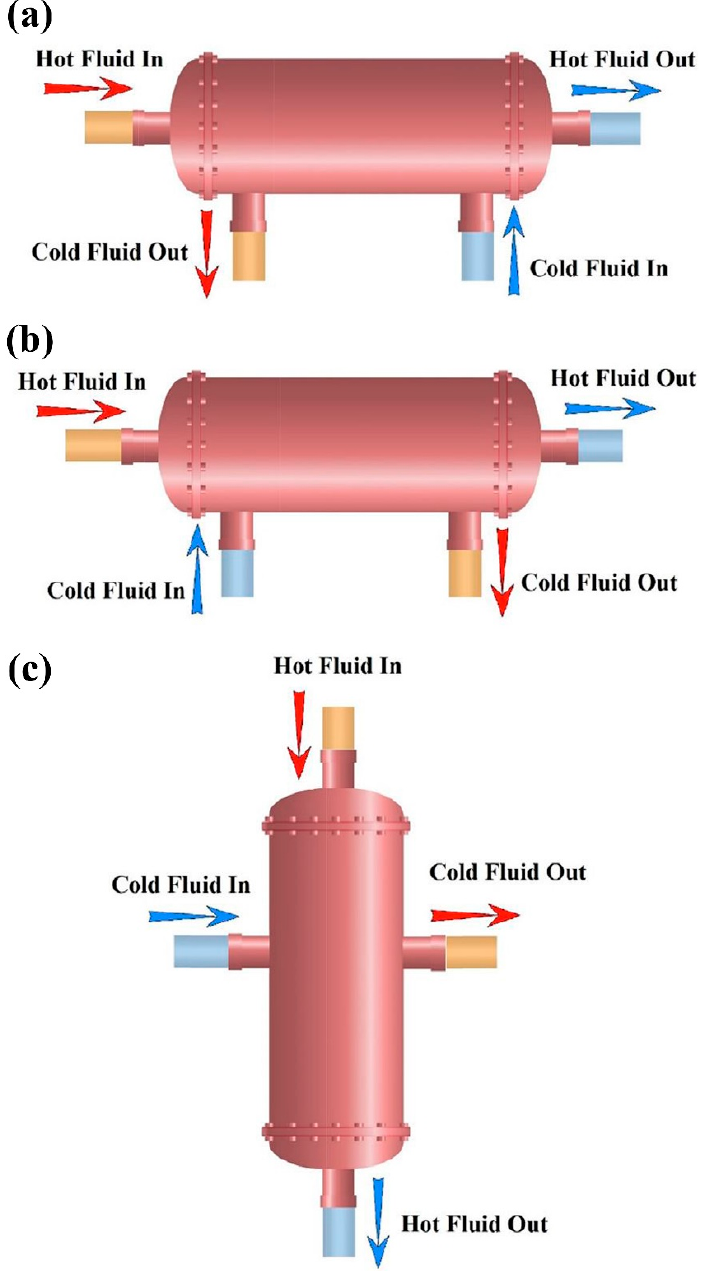
Figure 3. Different types of flow arrangements in intercoolers, where ( a – c ) shows the counterflow, parallel flow, and crossflow flows arrangements, respectively. Reproduced with permission from [21]. Elsevier, 2019.